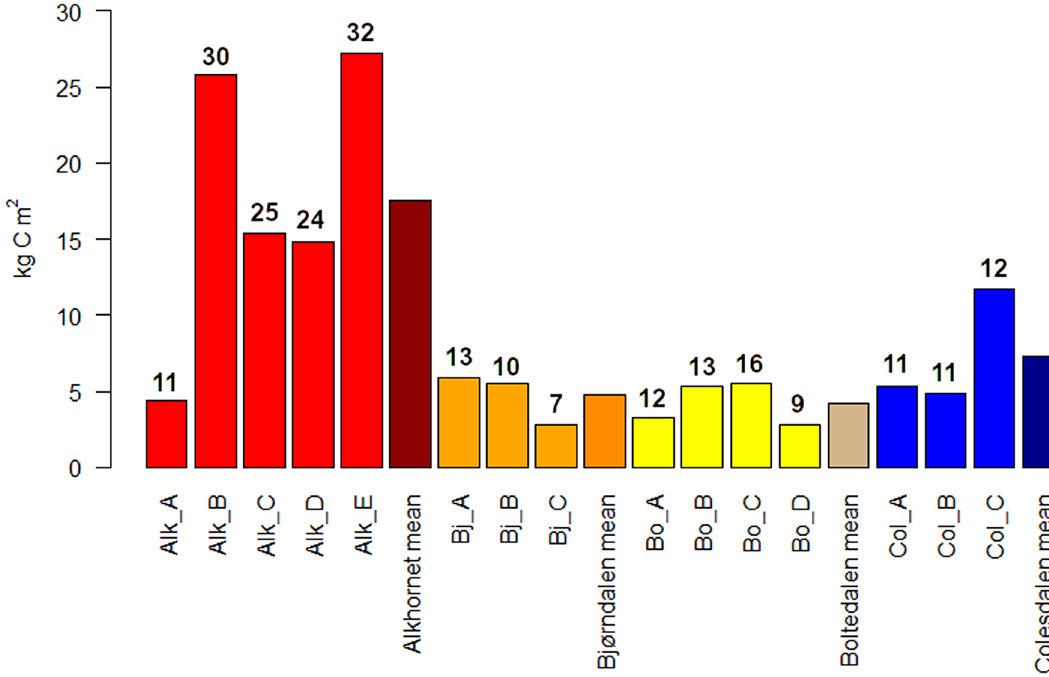
Figure 14. Carbon storage of the study points (kg C m -2 ) measured from the basal layer (Alk_A and study sites Bjørndalen, Bolterdalen and Colesdalen) or from the bottom of the active layer (Alk_B, Alk_C, Alk_D and Alk_E). In addition, mean carbon storage for each study site is included. Values above each bar represent thickness of the organic layer of the study points in